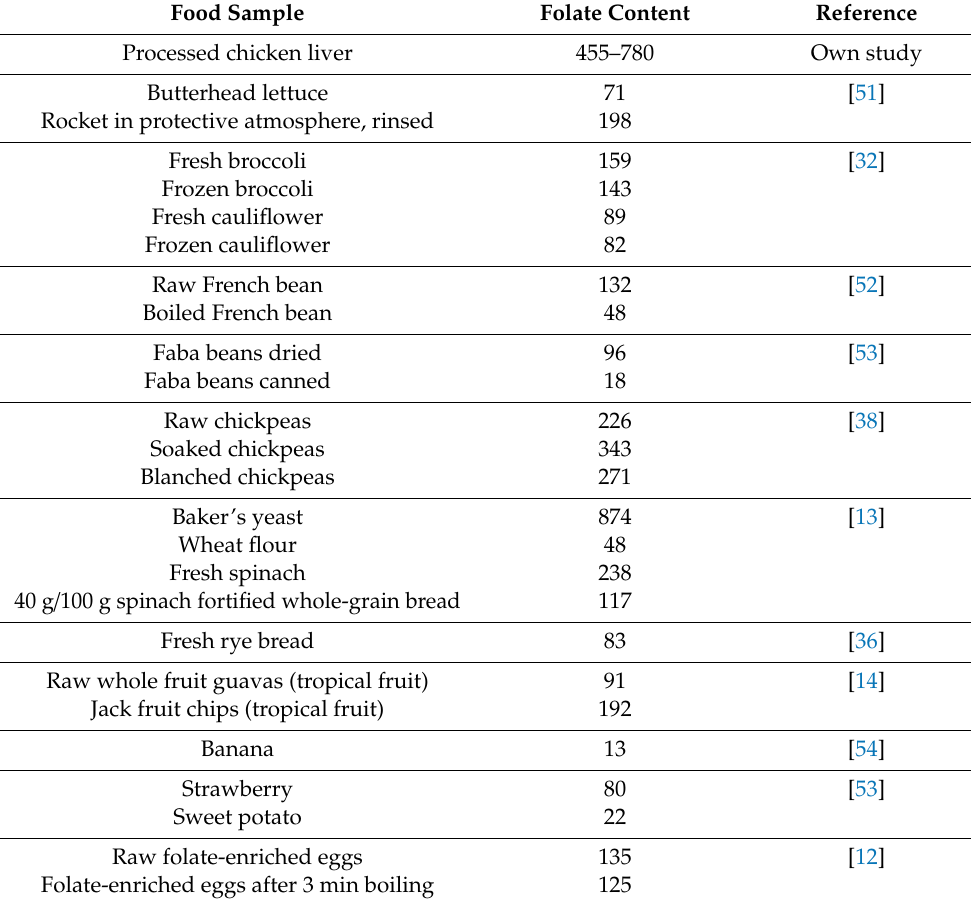
Table 3. Folate content in raw and processed food samples ( µ g / 100 g